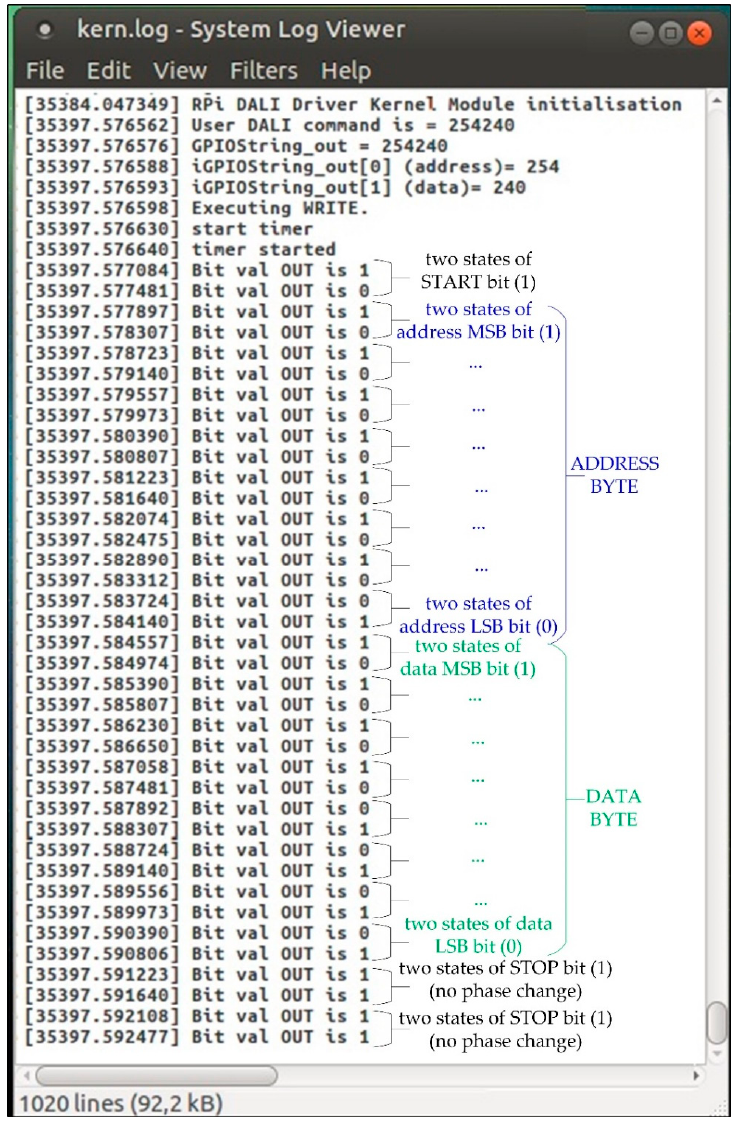
Figure 9. DALI kernel module output execution of a direct arc level command (FEF0).